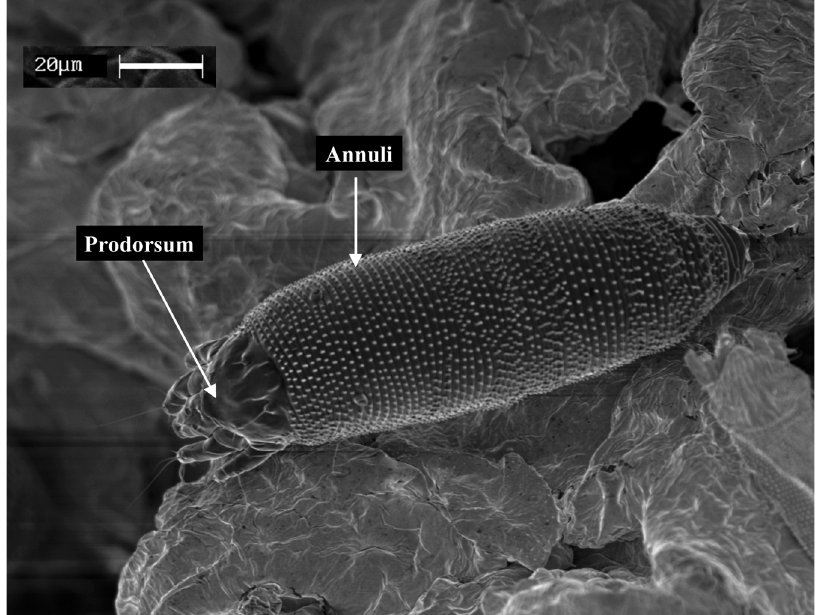
Fig. 9. A “vermiform” eri- ophyid mite ( Phytoptus avellanae